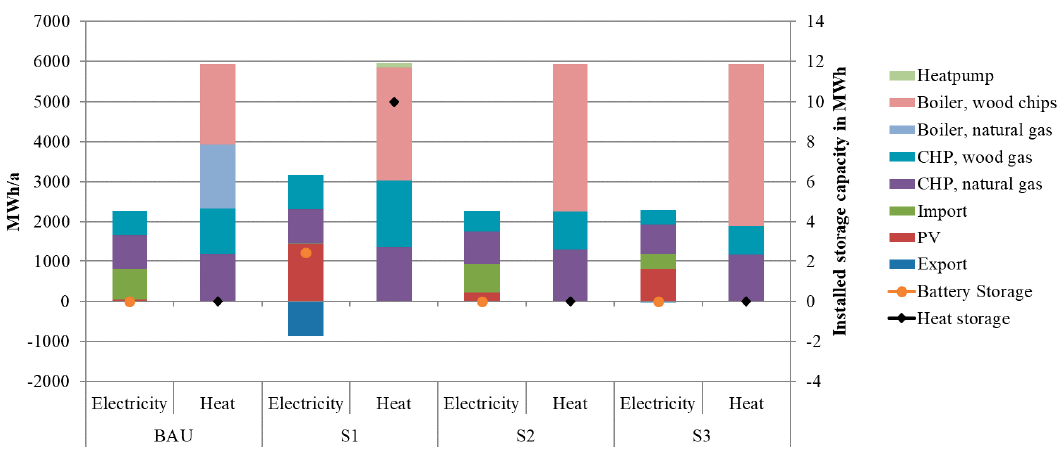
Figure 2. Energy supply and storage technology for all scenarios (CHP = combined heat and power plant; PV = photovoltaic plant). Table 2. Potentials and restrictions for optimization of the case study